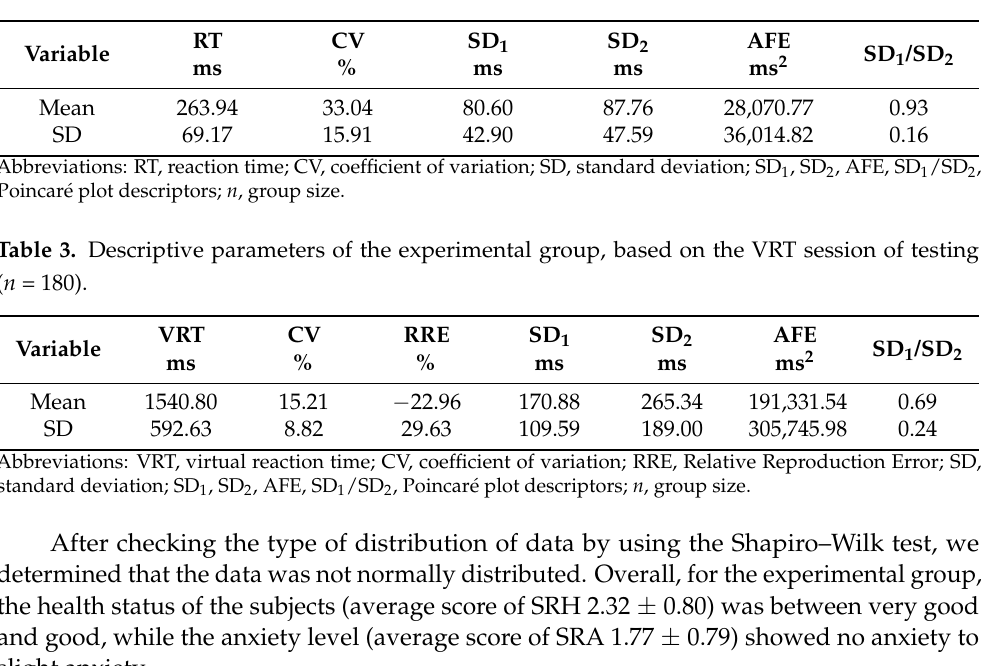
Table 2. Descriptive parameters of the experimental group, based on the RT session of testing ( n = 180).